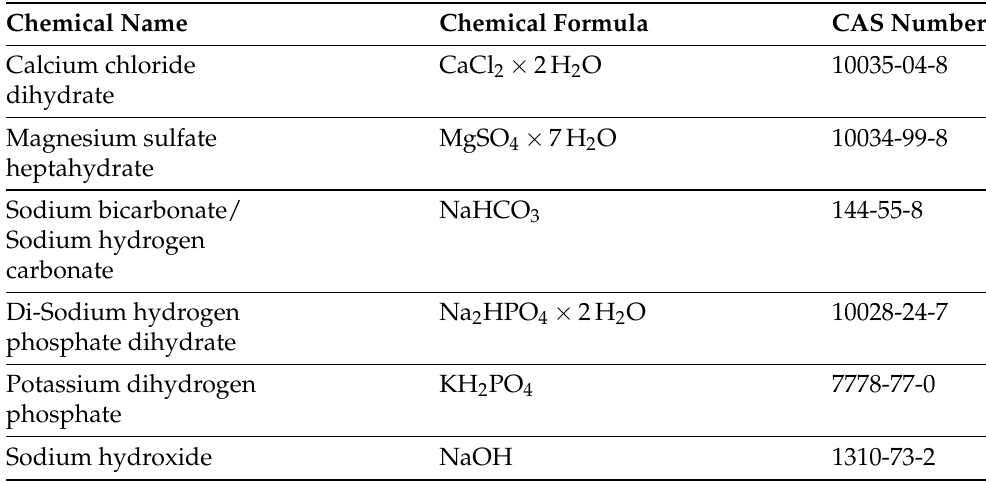
Table 3. Chemicals required for the preparation of the test